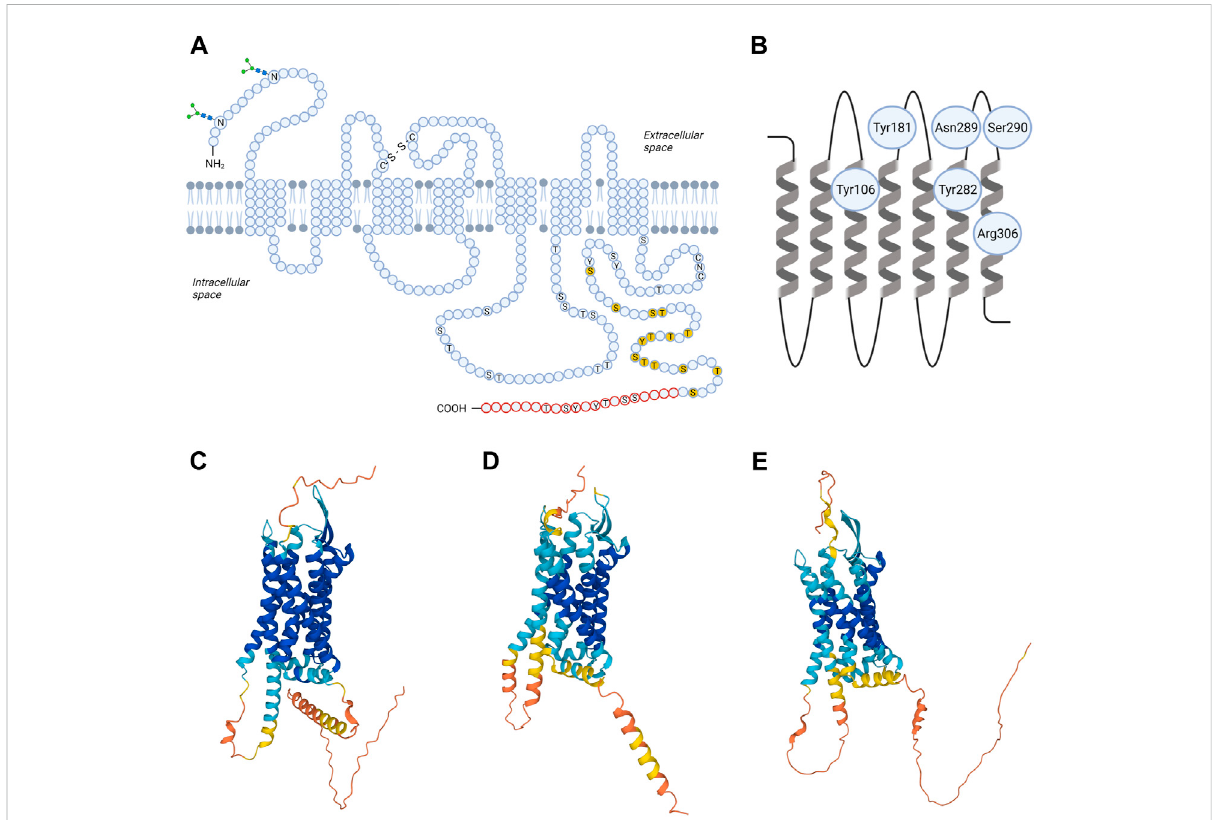
FIGURE 1 Structural models of TRH receptor. Shown is schematic two-dimensional topology (A) and ribbon model of rat TRH-R1 with amino acid residues possibly involved in TRH binding (B) and three-dimensional (3D) models of TRH-R1 (C) , TRH-R2 (D) and TRH-R3 (E) . TRH-R is an integral membrane protein containing seven membrane-spanning helices with an extracellular N-terminus and an intracellular C-terminus. The transmembranehelicesareconnectedbythreeextracellularandthreeintracellularloops.Asn3andAsn10areglycosylated( “ sugartrees ” onthe N-terminus).Cys98inthe fi rstandCys179inthesecondextracellularlooparelinkedbyadisulphidebond.TwentyC-terminalaminoacids(inred)are missingintheshortformofTRH-R.Residues335-337(CNC)andphosphorylatableresiduesintheC-terminalregionandIC3looparedenotedbythe one-letter code; those already shown to by critical for desensitization/internalization of the receptor are highlighted in yellow. C, Cys; N, Asn; S, Ser; T, Thre; Y, Tyr; -S-S- disulphide interaction. 3D structural models for rat TRH-R1 with UniProt ID Q01717 (C) , rat TRH-R2 with UniProt ID Q9QWW3 (D) ,andchickenTRH-R3withUniProtIDA0A4P9IVJ2 (E) wereprovidedbytheAlphaFoldDatabase(https://alphafold.ebi.ac.uk).Thecolor scheme represents the model con fi dence. AlphaFold produces a per-residue con fi dence score (pLDDT) between 0 and 100. The colors dark blue, light blue, yellow, and orange represent very high (pLDDT > 90), medium (90 > pLDDT > 70), low (70 > pLDDT > 50), and very low (pLDDT < 50) con fi dence, respectively. Some regions below 50 pLDDT may be unstructured in isolation. The fi gure was created by